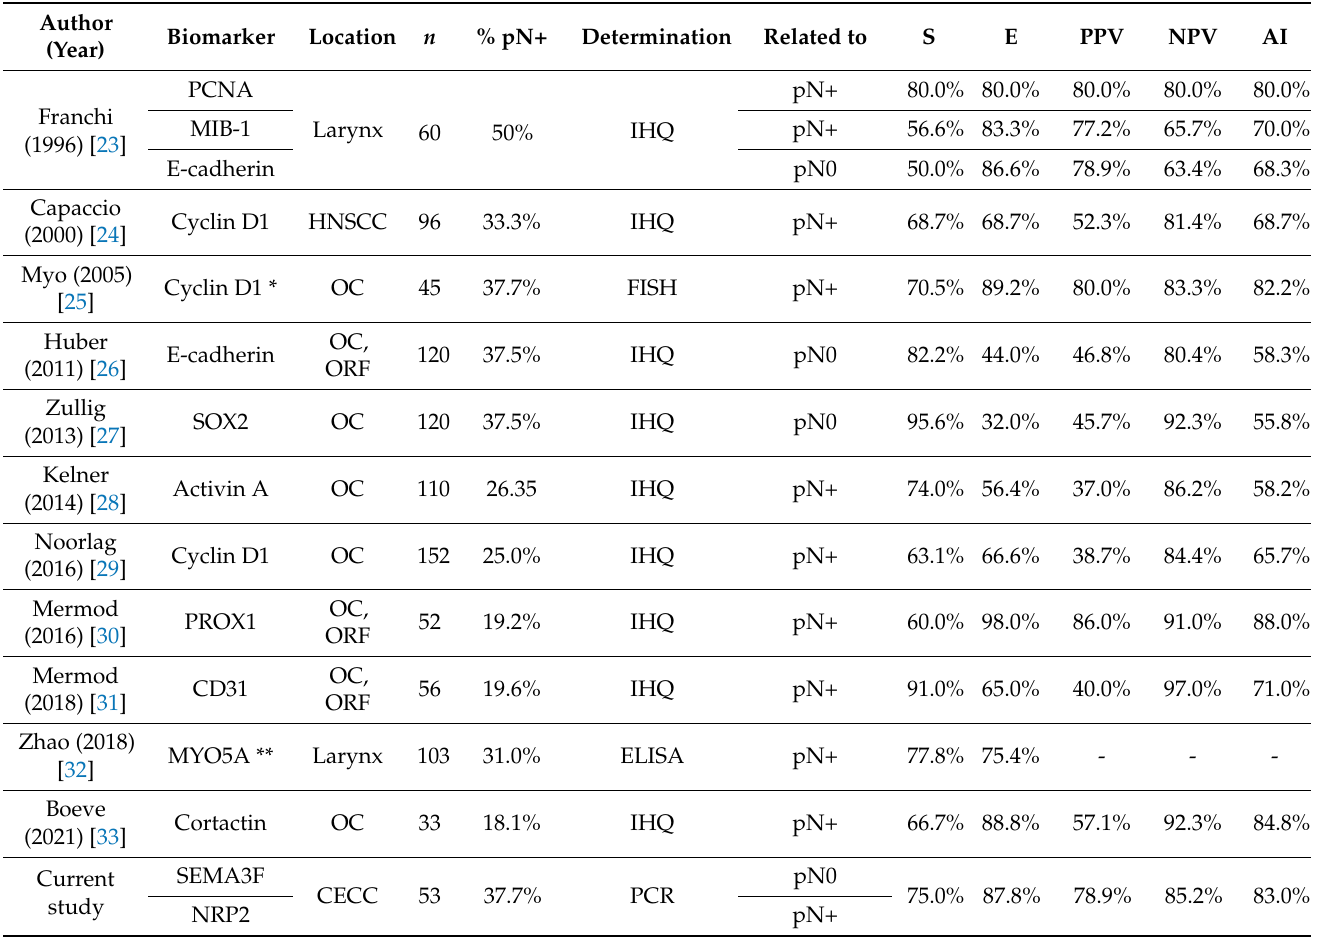
Table 3. Results obtained in studies that have analyzed the relationship of molecular biomarkers with the presence of occult lymph node metastases in patients with HNSCC (S, sensitivity; E, specificity; PPV, positive predictive value; NPV, negative predictive value; AI, accuracy index; OC, oral cavity; ORF, oropharynx; HNSCC, head and neck squamous cell carcinoma; IHC, immuno-histochemistry). * Numerical aberrations of CCND1; ** Serum MYO5A